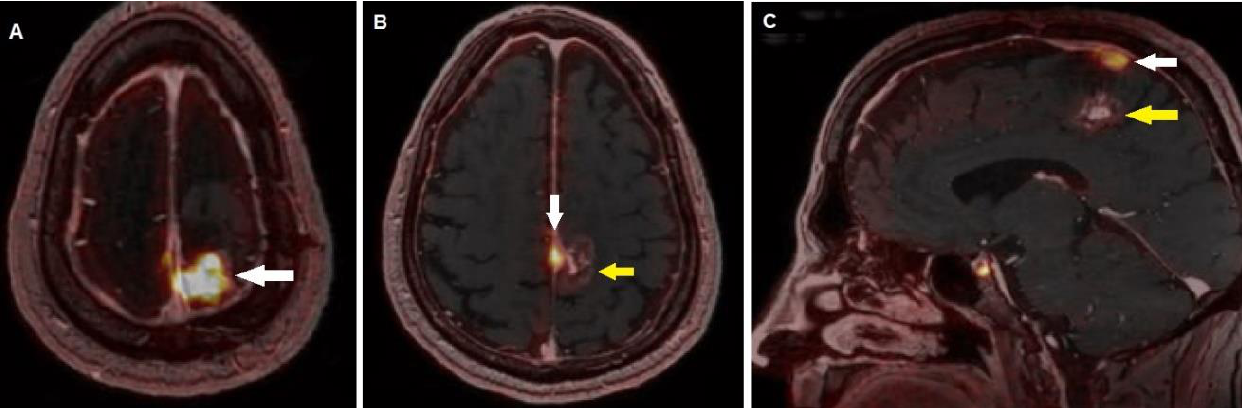
Figure 4. A 60-year-old male patient, previously submitted to surgery for a left parietal WHO grade III meningioma, then relapsed and treated with Gamma Knife. A 6-month post RT follow-up 68 Ga- DOTATOC PET and contrast-enhanced T1-weighted co-registered MRI axials revealed increased tracer incorporation within the left parietal meningioma ( A , white arrow), also detecting a focus of additional uptake in the falx cerebri ( B , white arrow) adjacent to an area of “soap-bubble” contrast- enhancement of the brain parenchyma ( B , yellow arrow), not characterized by meaningful tracer uptake, interpreted as radionecrosis. Sagittal fused PET/MRI ( C ) also well depicted the residual meningioma in the parietal region (white arrow) and the radionecrosis (yellow arrow).